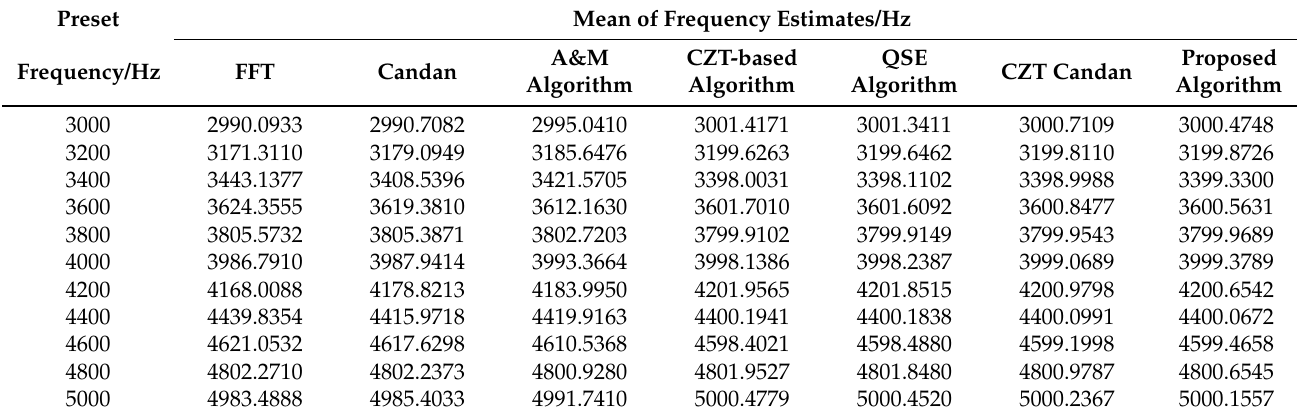
Table 2. Means of the frequency estimates versus the frequency when the SNR is 10 dB.